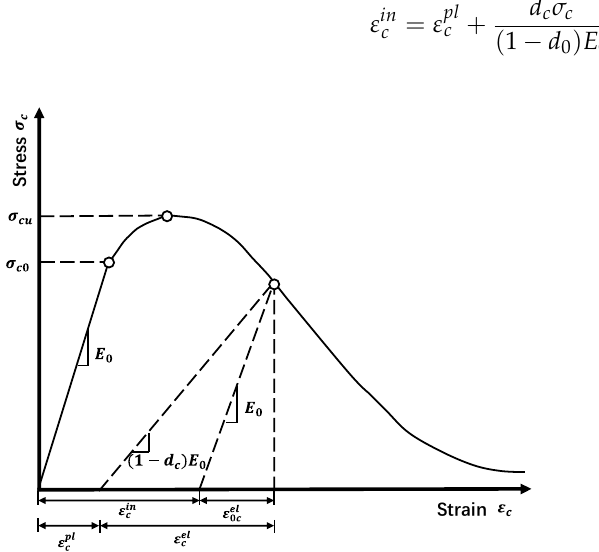
Figure 5. Stress–strain relationship of concrete under the compression condition considered in the present